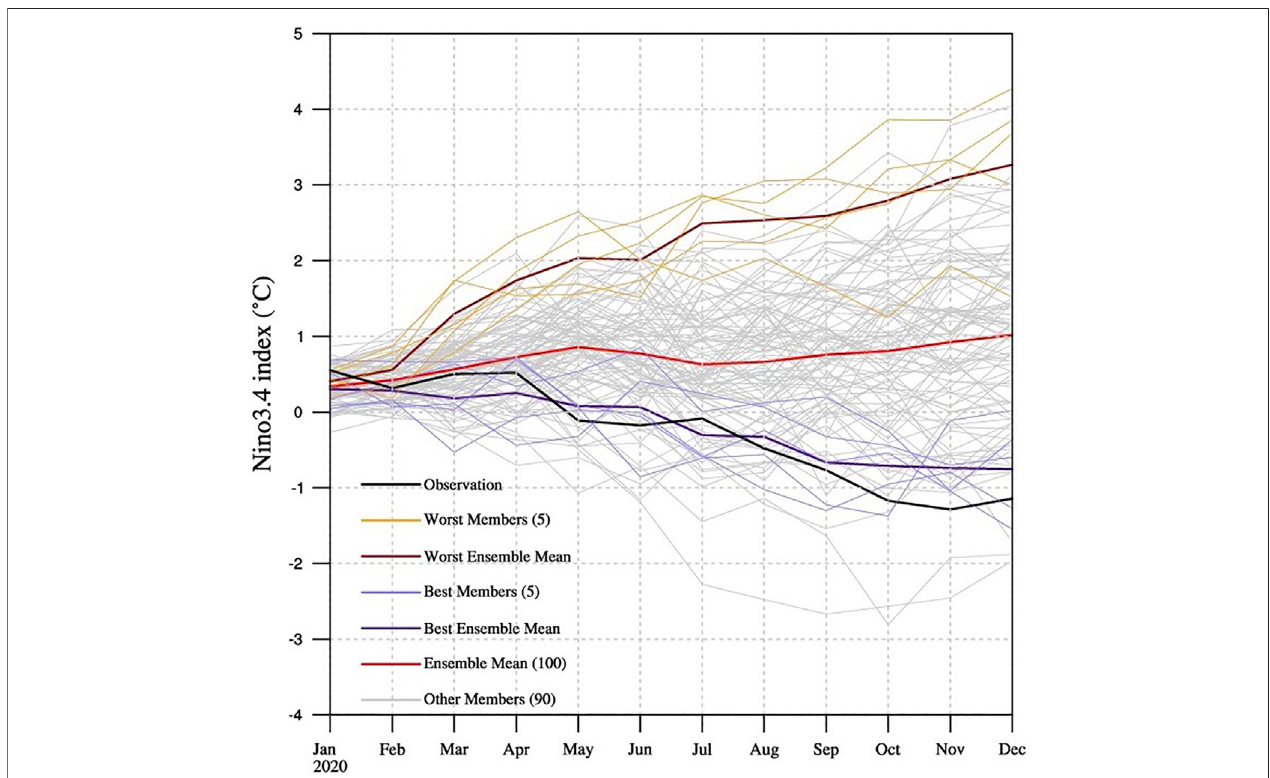
FIGURE 5 | The temporal variation in the Niño3.4 index in 2020 of observations (black line) and of the best and worst prediction members selected by pattern clustering. The red line represents the ensemble mean from all 100 ensemble members. The purple lines represent the best fi ve ensemble members (light) with the best ensemble-mean forecast (dark), the orange lines represent the worst fi ve ensemble members with the worst ensemble-mean forecast (dark red line), and the gray lines represent other ensemble